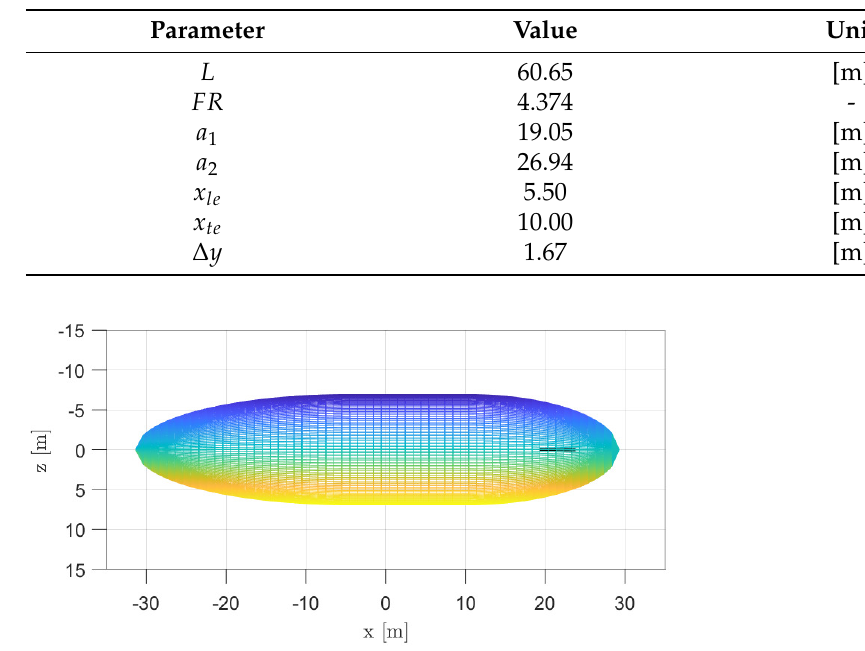
Figure 4. HiSentinel80 modeled geometry, considered for